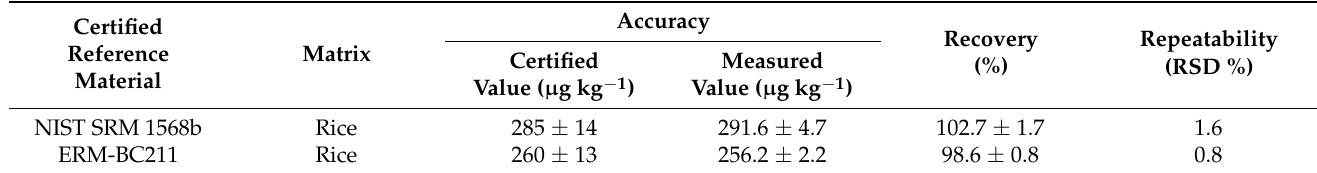
Table 1. Accuracy and repeatability of the method for evaluating total As. Total As content is ex- pressed as As μ g kg − 1 dry mass (mean ± SD, n = 6).